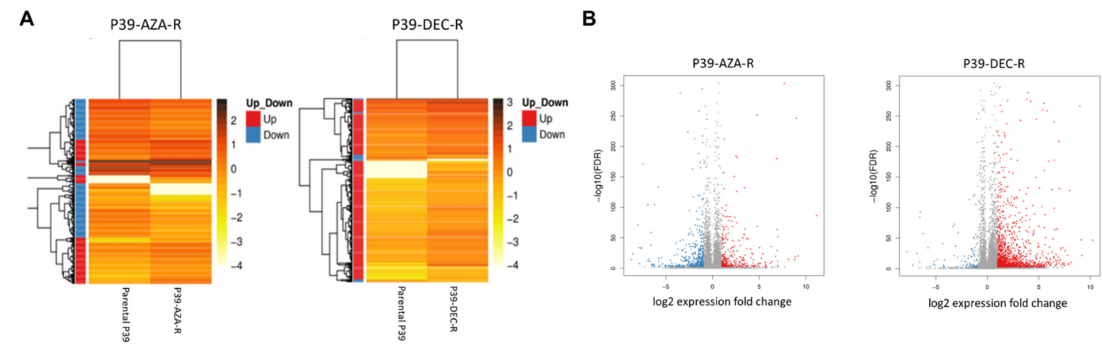
Figure 2. Differential expression profile of hypomethylating agent (HMA)-resistant P39 cells. ( A ) RNA expression profiles of AZA-resistant P39 (P39-AZA-R) and DEC-resistant P39 (P39-DEC-R) were distinct from each other with different clustering pattern; ( B ) Volcano plot of differentially expressed genes. Overexpression of genes was seen in P39-DEC-R and P39-AZA-R when compared with P39. The upregulated genes (blue) correspond to their negative log10 false discovery ratio (FDR) ( p -value). P39-DEC-R (right) detected 1296 significantly upregulated genes (red dots) while P39-AZA-R (left) detected 306 significantly upregulated genes when compared with P39. There were 420 downregulated genes detected in P39-AZA-R and 89 downregulated genes detected in P39-DEC-R in comparison with P39.